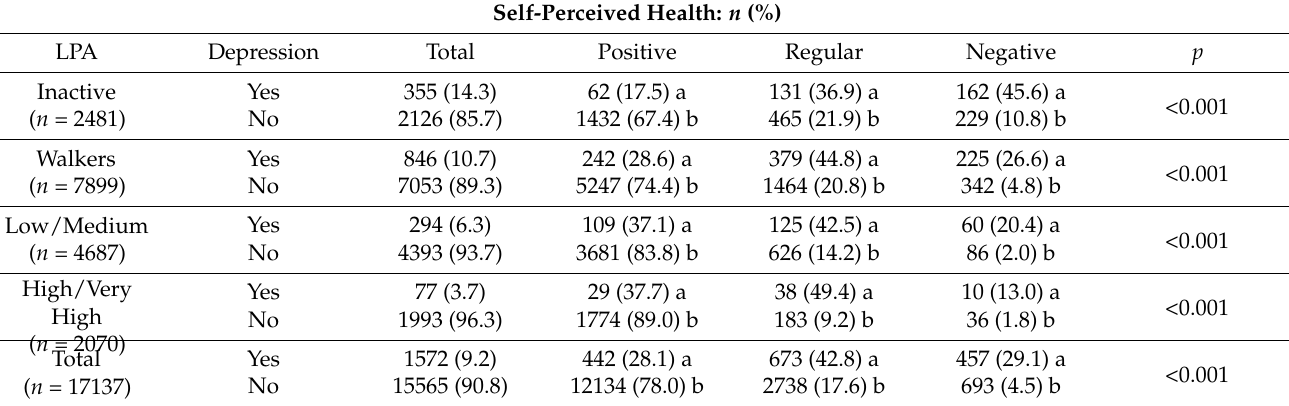
Table 2. Relationship between the prevalence of depression and self-perceived health in the general Spanish population of the ENSE 2017 aged between 18 and 69 years, and according to the level of physical activity.